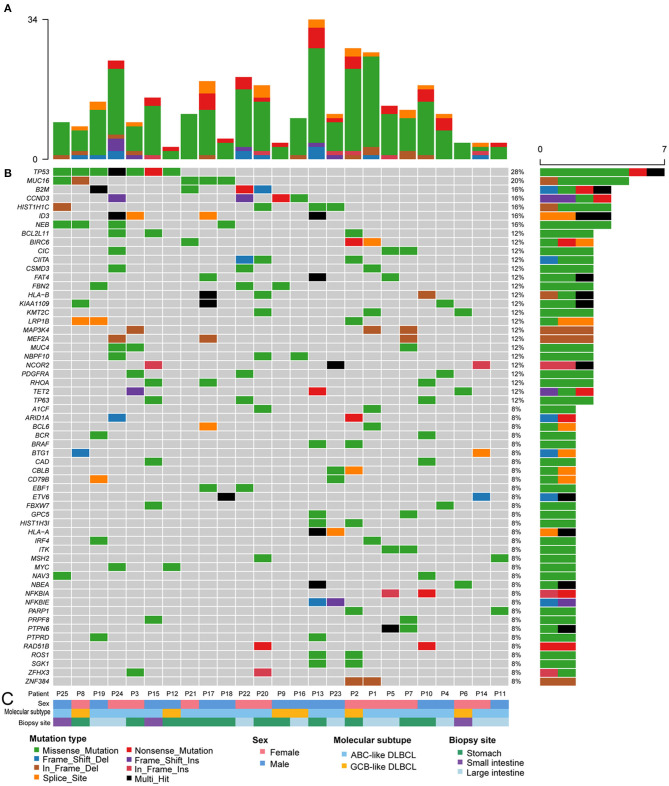
Recurrently mutated oncogenes in 25 patients with GI-DLBCL. (A) The absolute number of oncogenic mutations in each patient. (B) Fifty-nine recurrently and significantly mutated genes constitute the individual rows and are sorted according to their mutational frequencies. The heatmap represents individual mutations in 25 patient samples color-coded by the mutation type. Right: histogram shows the number of mutations in each gene. Percentages represent the fraction of tumors with at least one mutation in the specified gene. (C) Tracks at the bottom of the plot provide information on sex, the molecular subtype and biopsy site. Bottom: the mutation type, sex, molecular subtype, and biopsy site are color-coded as indicated in the legend.